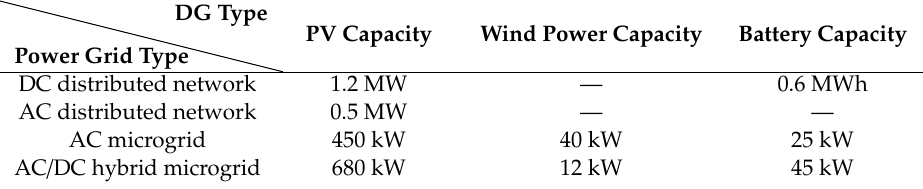
Table 3. Configuration results of microgrid and distribution network DG collaborative